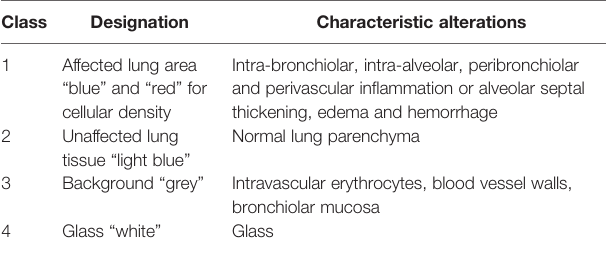
TABLE 1 | Scoring classi fi cation of hamster lung